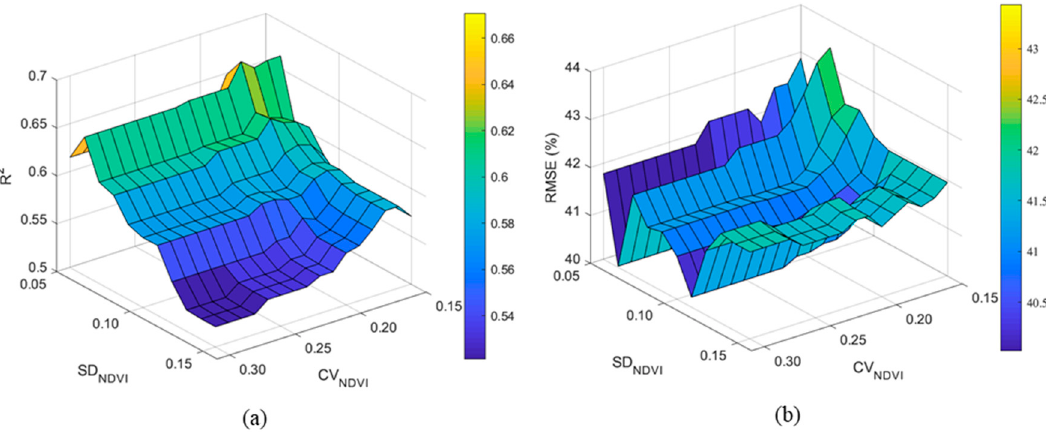
Figure 4. Three-dimensional maps showing R 2 ( a ) and RMSE ( b ) between LFMC observations and estimations with the variation of the threshold values of CV NDVI and SD NDVI used to filter out sites that are heterogeneous within the MODIS footprint.